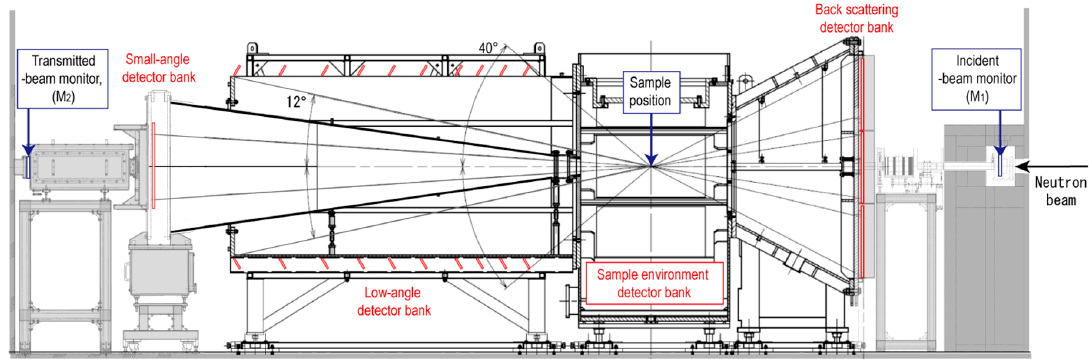
Figure 1. iMATERIA spectrometer at J-PARC, with neutrons entering from the right to the detectors at the left.